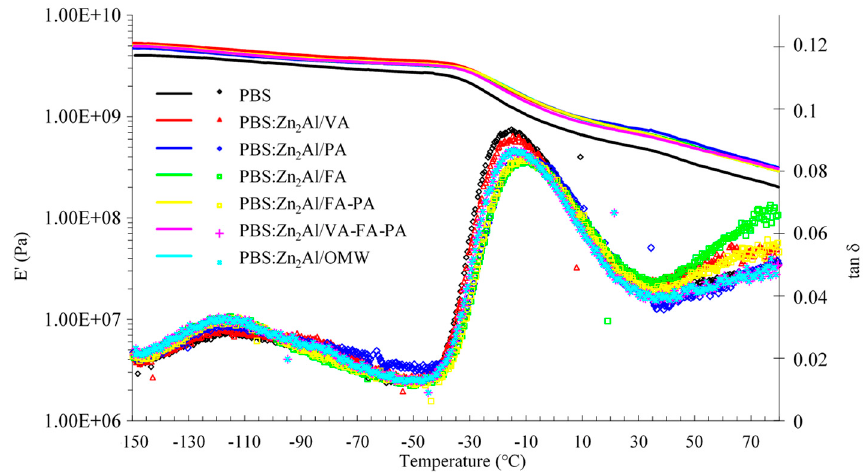
Figure 4. DMTA profiles of PBS and PBS:Zn 2 Al / X composites.